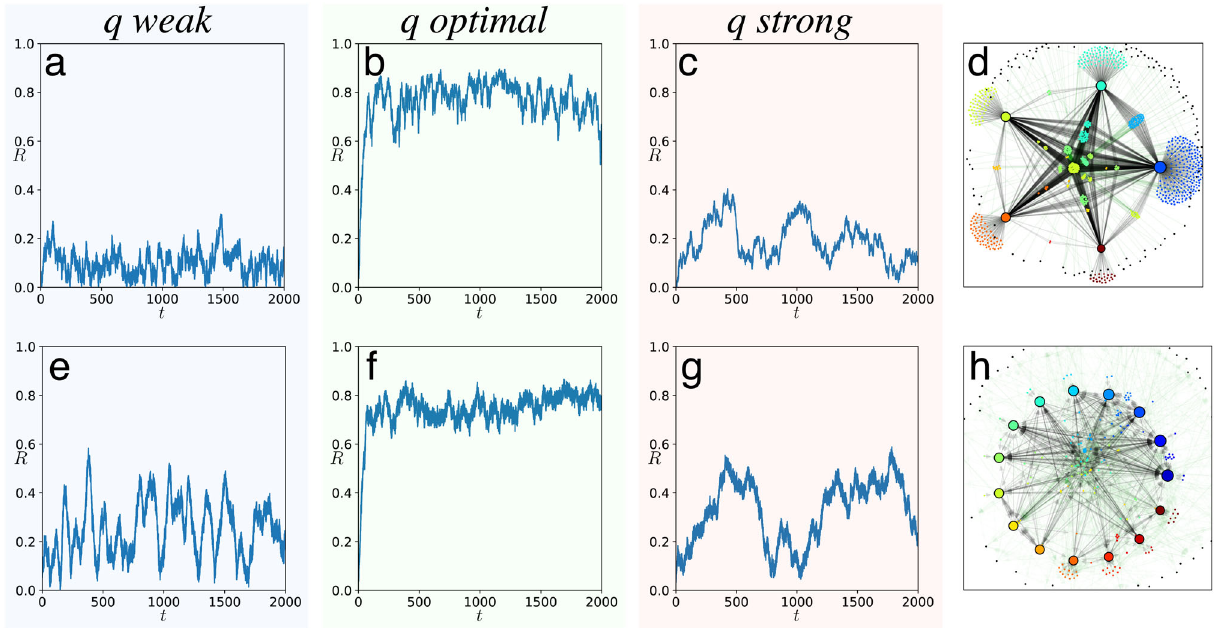
Fig. 2 Coherence resonance of the order parameter in different complex networks. a – c , e – g The time series of the order parameter R for three values of noise strength in the in fl uencers for weak q = 0.1 ( a , e ), optimal q = 1 ( b , f ), and strong q = 10 ( c , g ). d , h show the corresponding networks with d a scale- free network with exponent 2 1 and h C. elegans directed neural network 3 . See Methods for further details. Additional examples can be found in Supplementary Note